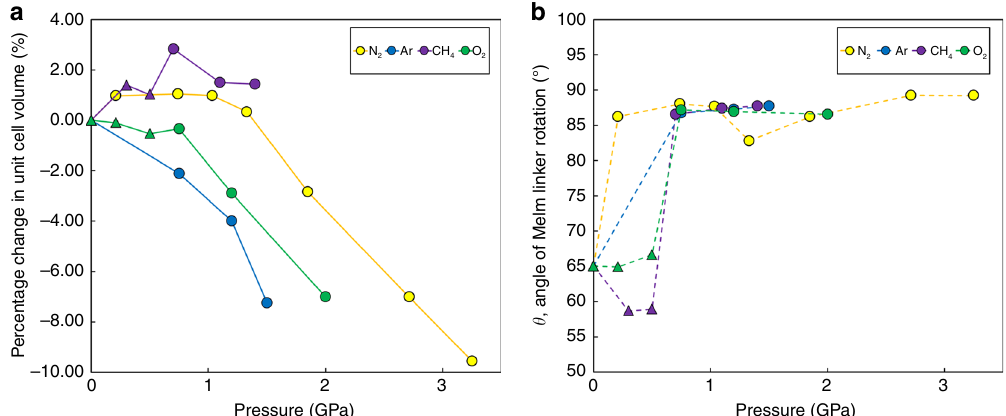
Fig. 2 Compression and linker rotation in ZIF-8. a Change in unit cell volume of ZIF-8 with pressure for N 2 (yellow), CH 4 (red), Argon (blue), O 2 (green); b Change in angle of rotation of MeIm linker, θ , in ZIF-8 upon increasing pressure for N 2 (yellow), O 2 (green), Ar (blue) and CH 4 (magenta). Triangles and circles indicate ZIF-8-AP and ZIF-8-HP phases, respectively